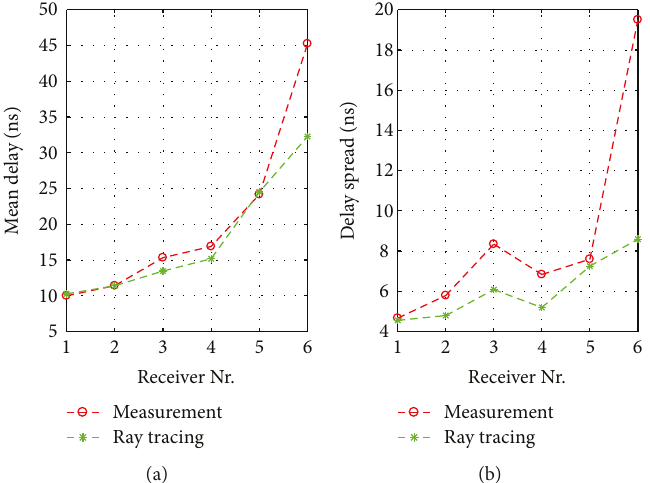
Figure 14: Measured and RT-simulated mean delays (a) and delay spread (b) for all Tx positions for the basement